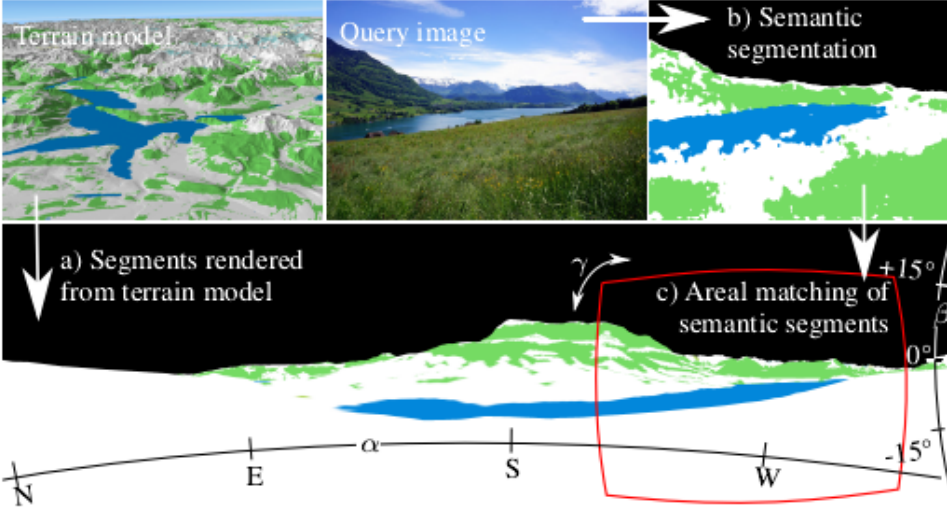
Figure 5. Camera pose estimation based on semantic segmentation. Through semantic segmentation of the image, various geomorphic regions are identified, and the camera orientation is determined by matching with the terrain model containing GIS